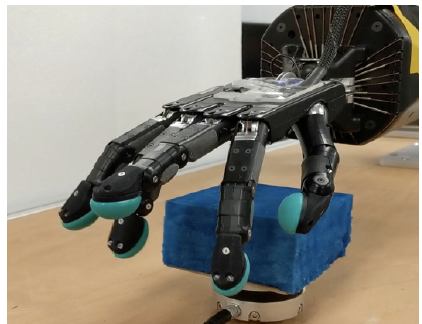
Figure 7. Gentle object manipulation with an anthropomorphic robotic hand